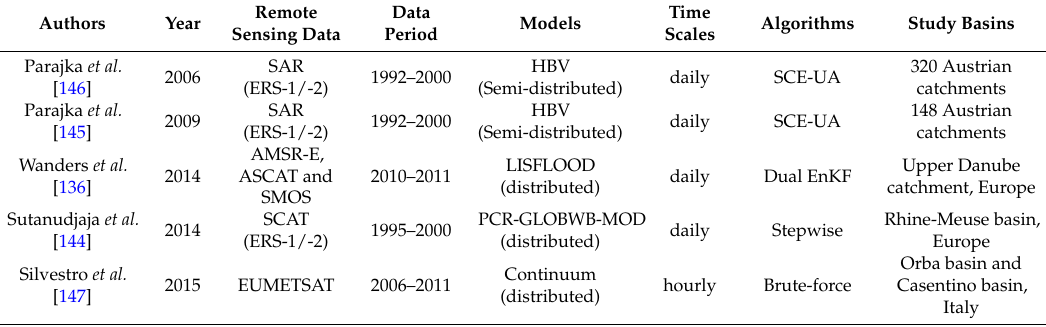
Table 3. Studies calibrating a flood forecasting model using remotely sensed soil moisture